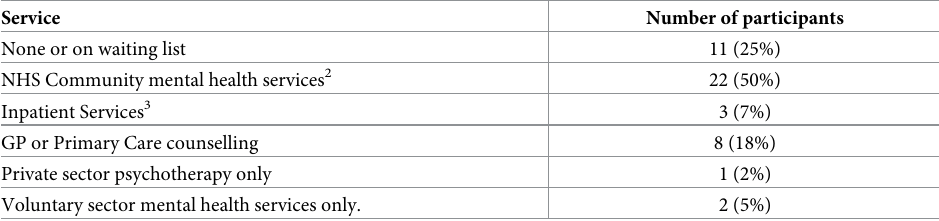
Table 3. Mental health services accessed by